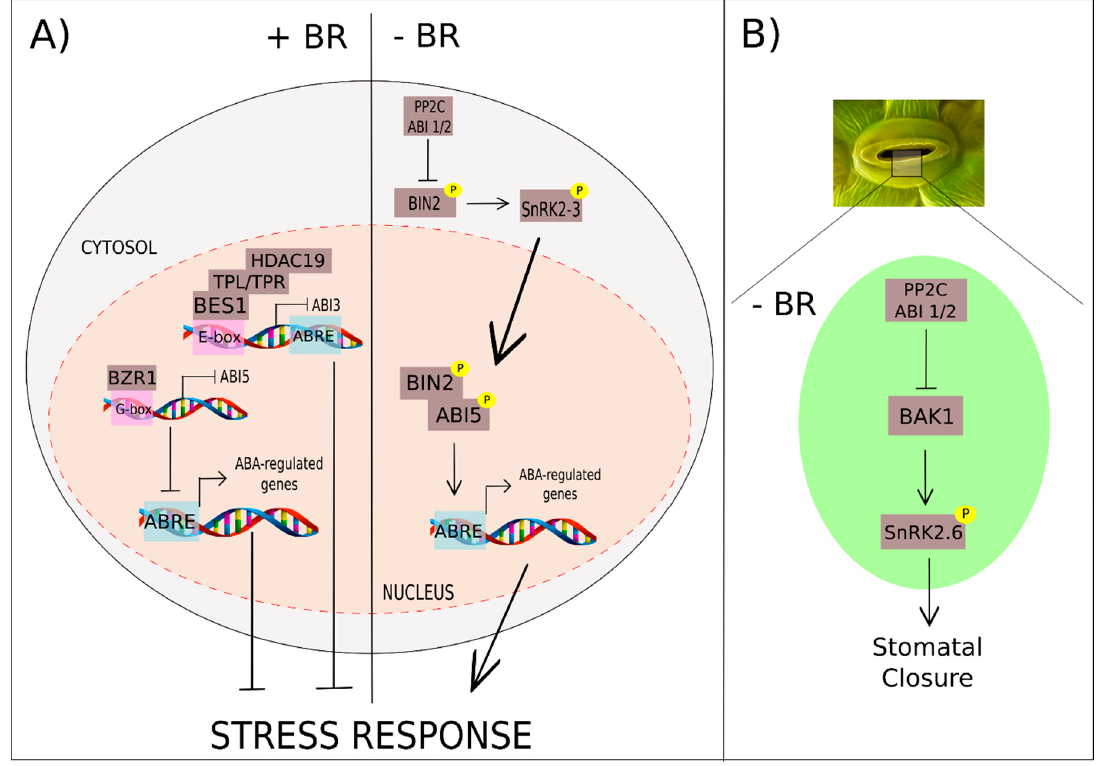
Figure 7. BR and ABA cross-talk relies on protein activity modulation and gene expression regulation. ( A ) In the presence of BR, the complex formed by BRI1-EMS SUPPRESSOR 1 (BES1), TOPLESS/(TPL/TPR) and HISTONE DEACETYLASE 19 (HDAC19) inhibits ABA Insensitive 3 ( ABI3 ) expression by interacting with E-box promoter sequences. The transcription factor BRASSINAZOLE RESISTANT 1 (BZR1) interacts with the G-box sequences of the ABI5 promoter, leading to gene repression. Repression of the ABI3 and ABI5 genes results in lower expression of ABA-regulated genes and decreased stress responses. At low levels of BR, stress responses are stimulated by SnRK2.3 activation by BRASSINOSTEROID-INSENSITIVE 2 (BIN2). Additionally, the BR-repressor BIN2 phosphorylates the transcription factor ABI5 , resulting in the expression of ABA-related genes. ( B ) In guard cells, BRI1-ASSOCIATED RECEPTOR KINASE 1 (BAK1) phosphorylates the kinase SnRK2.6 at low levels of BR, driving stomatal closure responses. At low levels of ABA, the PHOSPHATASE 2C (PP2C) phosphatase ABI1 and ABI2 repress SnRK2.6 phosphorylation by BAK1 and also the phosphorylation of SnRK2.3 by BIN2, decreasing stress responses related to ABA–BR cross-talk.